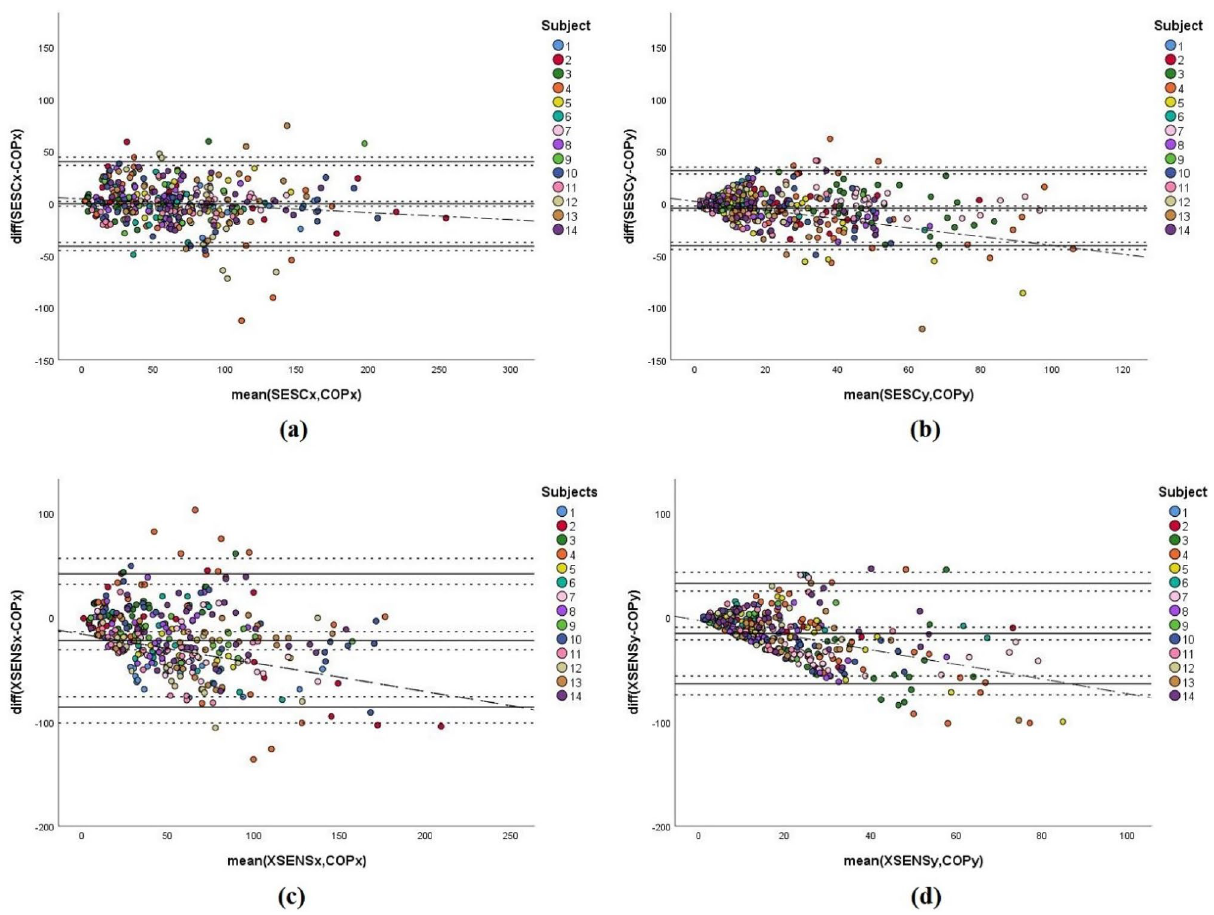
Figure 4. Bland–Altman plots of the CoM estimations against the CoP readings for subjects belonging to the Obese group. Mean bias and limits of agreement are shown by the straight black lines, while confidence intervals are shown by the dotted lines. ( a ) represents the SESC estimations in the AP direction, ( b ) represents the SESC estimations in the ML direction, ( c ) represents the XSENS estimations in the AP direction, and ( d ) represents the SESC estimations in the ML